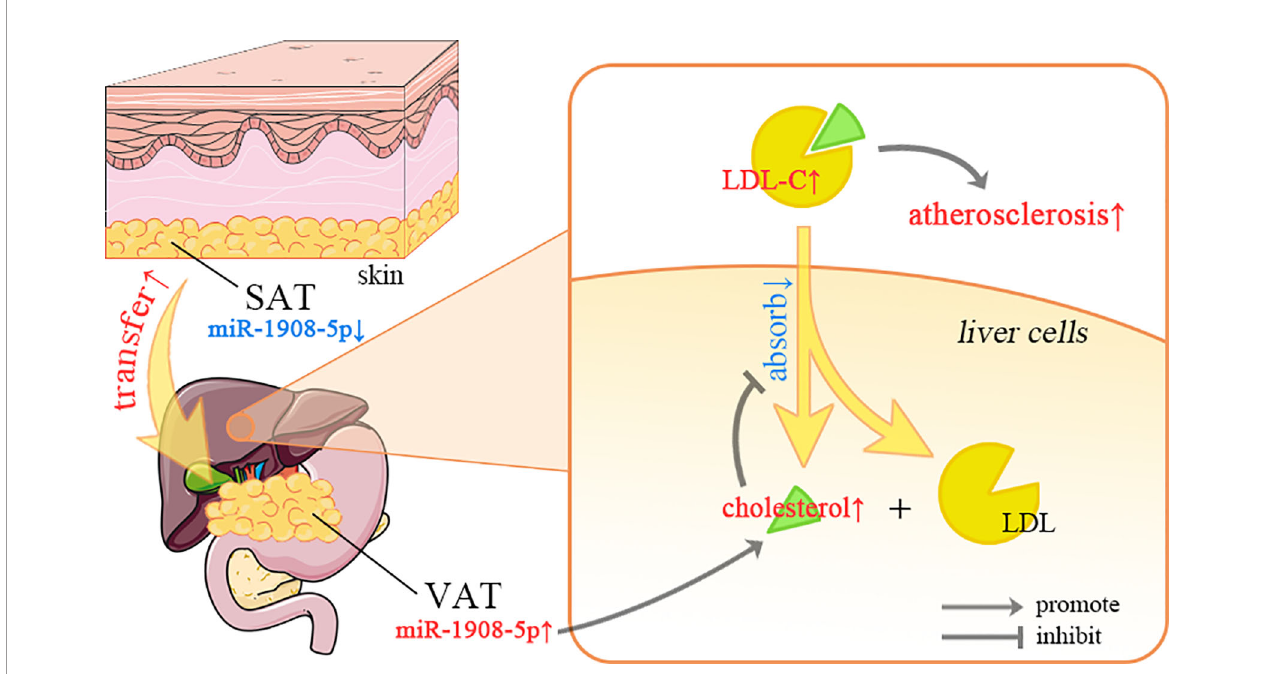
FIGURE 6 | The regulation of miR-1908-5p in lipid metabolism. SAT, subcutaneous adipose tissue; VAT, visceral adipose tissue; LDL-C, low-density lipoprotein cholesterol; The differential expression of miR-1908-5p in different organs may be related to the distribution of adipose tissue, and its abnormal expression may be related to fatty liver and atherosclerosis.